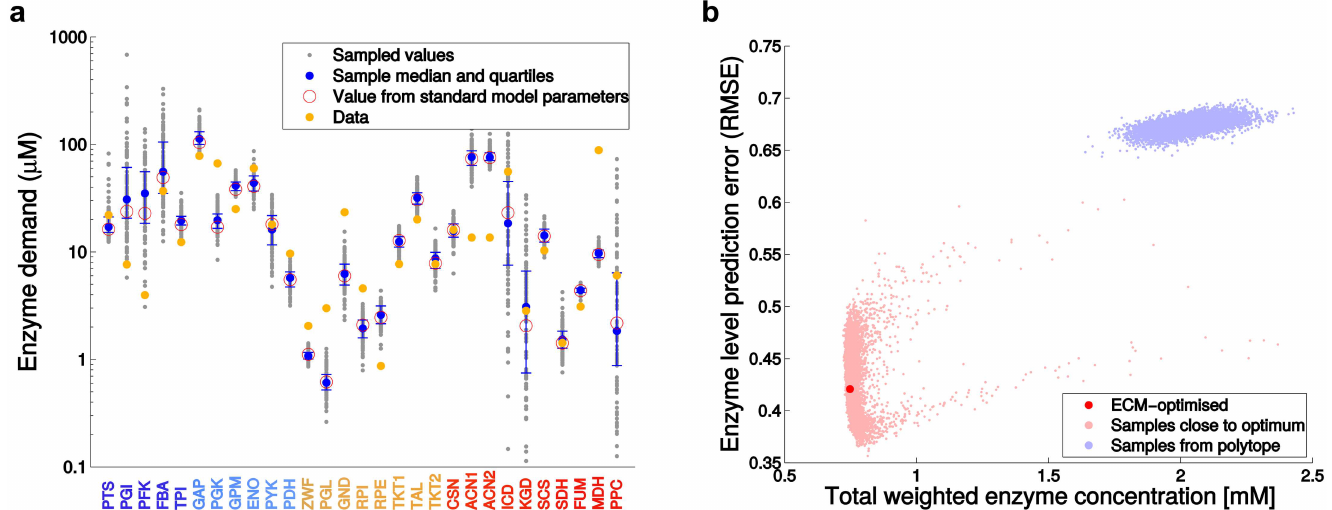
Fig 4. Prediction uncertainties and evidence for cost optimality. (a) Uncertainty of predicted enzyme levels due to uncertain model parameters. A hundredsets of kinetic model parameterswere generated by Monte Carlo sampling. Due to the multivariate distribution used for sampling, each parameter set satisfies the Haldanerelationships. At the same time, fluxes were sampled accordingto their experimental error bars (typically around 15% of the measured flux), and the fixed metabolite concentrations were randomly varied in a ± 5% range. The resulting predicted enzyme levels, computed using the EMC4cm score, are shown by small gray dots. Solid blue circles show medians, and error bars show 25% and 75% quantiles; empty red circles show the originalECM4cm prediction,i.e. without sampling.(b) The enzyme levels in E. coli appear to be cost-optimized. We compared the ECM solution (with ECM4cm score) to enzyme profiles obtained from metabolite profiles randomly sampled in the metabolitepolytope. The ECM solution (red) or metabolite profiles sampled in a close neighborhood (pink) yield significantly better enzyme predictions(quantifiedby RMSE, compare Fig 3) than metaboliteprofiles sampled in the entire polytope (light blue). The total enzyme cost (on x-axis) represents the sum of weightedenzyme concentrations (in mM); the weight of an enzyme is given by its amino chain length, divided by the medianchain length of all enzymes considered.